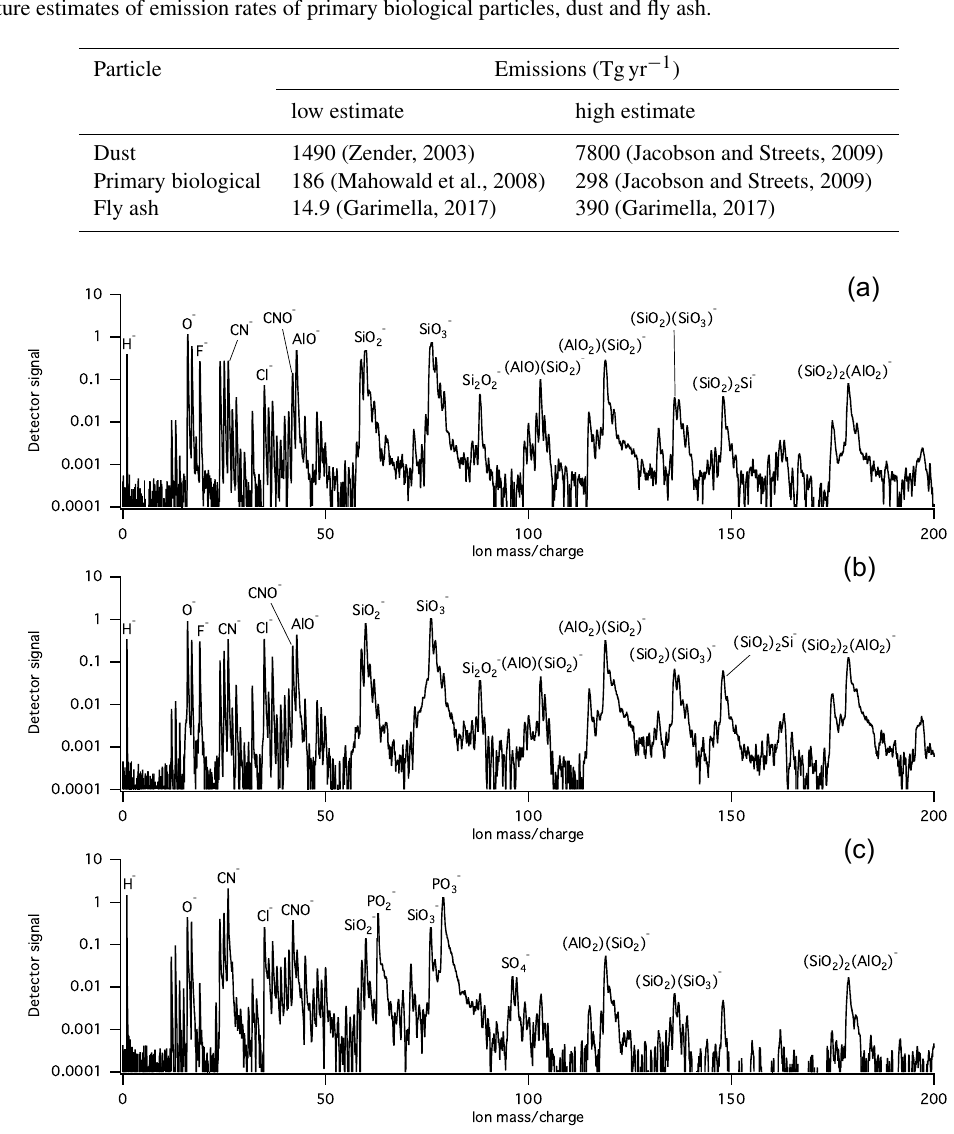
Figure 10. Exemplary PALMS negative polarity spectra of (a) : dry-dispersed illite NX; (b) : wet-dispersed illite NX from a distilled, deionized water slurry; (c) : similarly wet-dispersed illite NX but from a water slurry that also contained F. solani spores. Note that phosphate features are absent in (a) and (b) but present in (c) due to the addition of biological material to the mineral